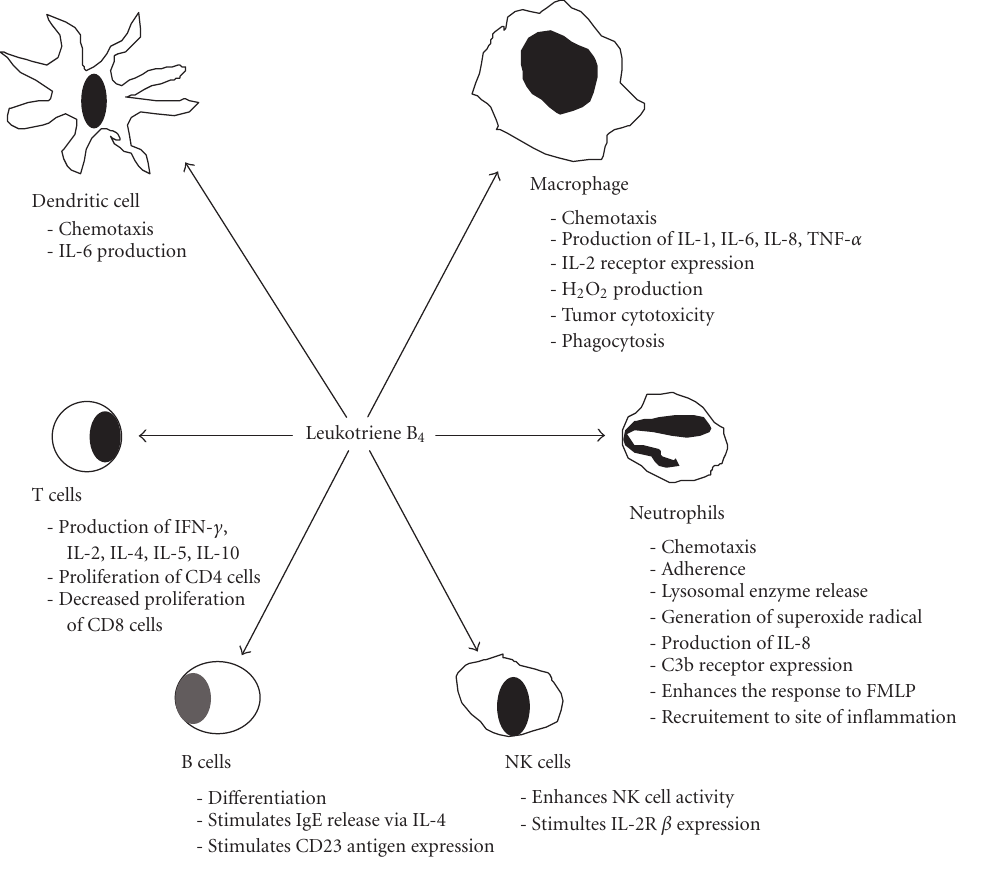
Figure 2. E ff ects of LTB 4 on cells of immune